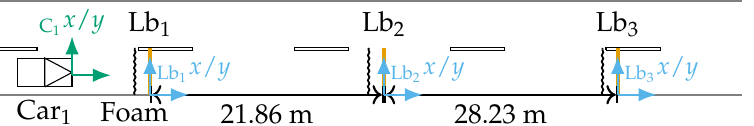
Figure 5. Measurement setup for super-referencing absolute positioning in the dynamic